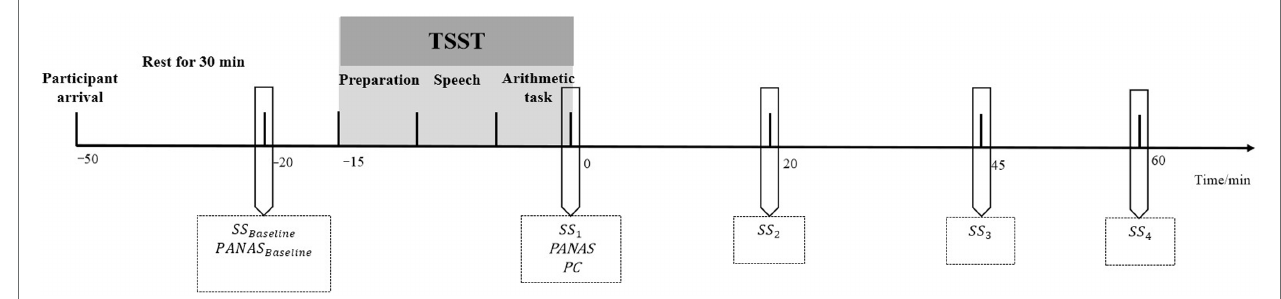
FIGURE 1 | General procedure. TSST, The Trier Social Stress Test; SS, saliva sampling; PANAS, the Positive and Negative Affect Scale; and PC, perceived control assessment. 0 indicates the end of the